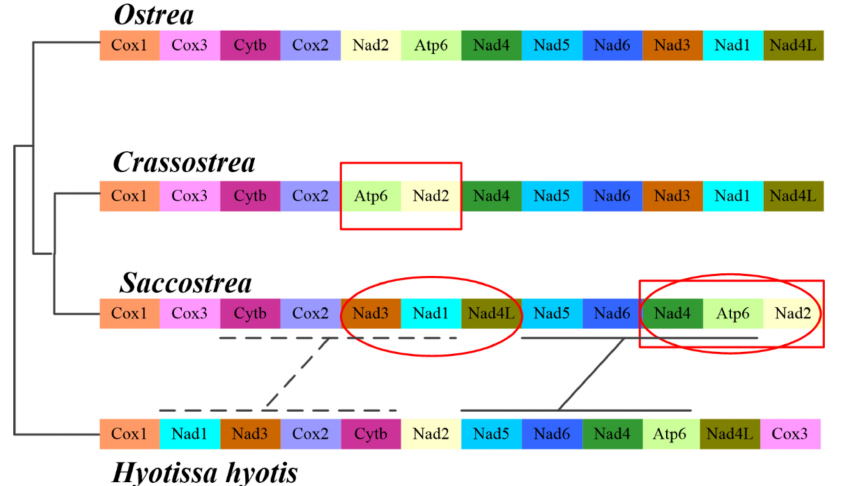
Figure 5. Linearized PCG order of Ostreidae (including Crassostrea , Saccostrea and Ostrea ) and Gryphaeidae (represented by Hyotissa hyotis only) based on the phylogenetic tree (see Figure 6 for detailed relationships). By assuming the PCG order in Ostrea as pleisomorphic of Ostreidae, the transversions and translocations (happened in Crassostrea and Saccostrea ) are indicated by red rectangular and oval boxs, respectively. The identical gene block ( Nad5 - Nad6 - Nad4 - Atp6 ) and the inverted gene block ( Nad1 - Nad3 - Cox2 - Cytb ) between H. hyotis and Saccostrea are marked by solid and dotted underlines, respectively.